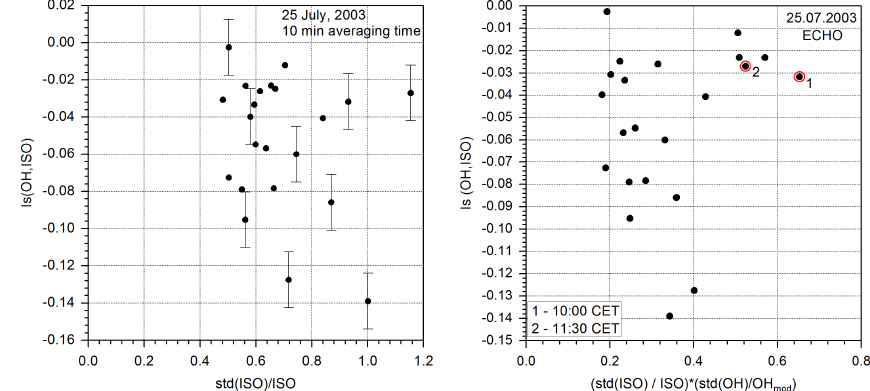
Figure 10. The dependence of the intensity of segregation on isoprene standard deviation (left) and normalised variance (right). The specific conditions for the red marked points are described in Sect. 4.2.5.